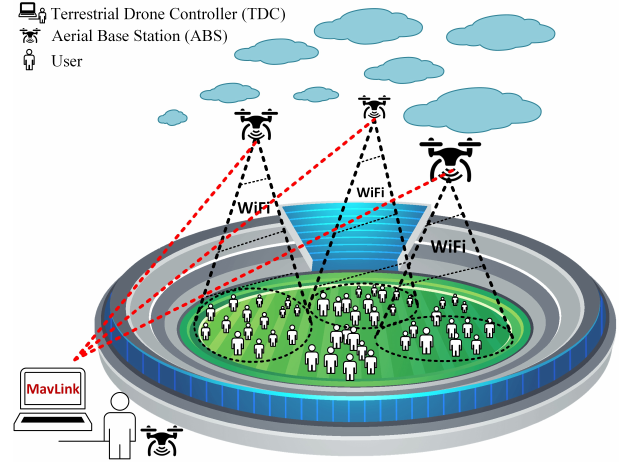
Figure 1. The network architecture